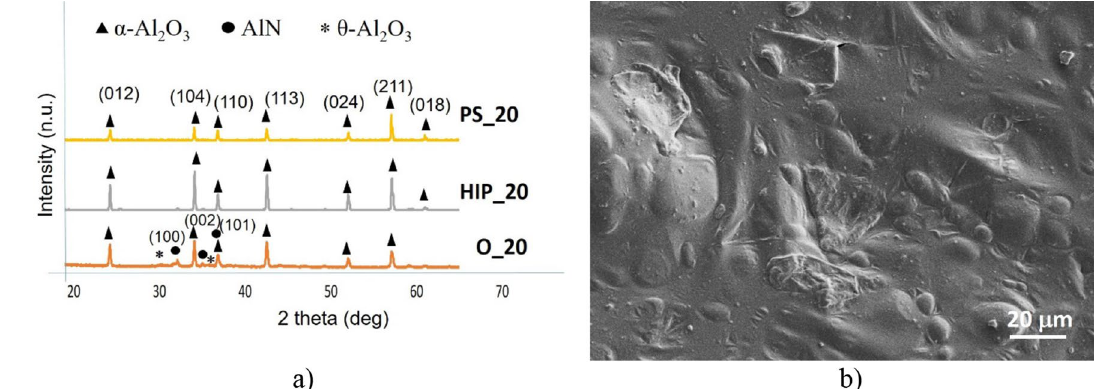
Figure 8. Investigation of oxidized AlN at 20 h. ( a ) XRD plots of oxidized AlN powder (O_20), HIP sintered (HIP_20) and sintered at H